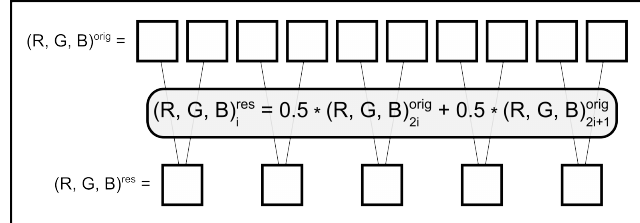
Fig. 3. Pixels selection of the artificial visual cortex. The central portion of the image captured by the virtual camera is reduced to five pixels by the arithmetic mean of RGB components from each two neighbor pixels. In the given formula, (R,G,B) orig is the array of the ten central pixels of the captured image and (R,G,B) res is the array of the five pixels resulting from the reduction, with i being the index of each